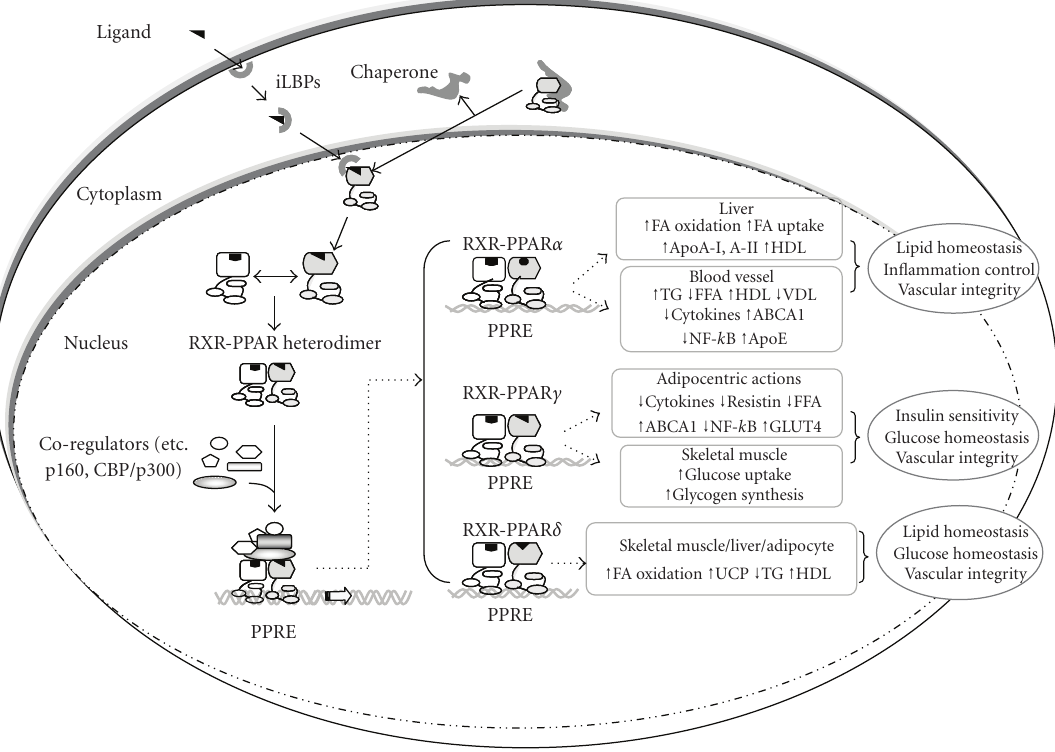
Figure 2: Signaling pathways activating PPAR and regulating the biological e ff ects of PPAR in di ff erent organs. PPAR activity can be regulated by the direct binding of small lipophilic ligands. Ligand-unbound PPAR in the cytosol is associated with chaperons, and the association changes the conformation of PPAR that allows for high-a ffi nity binding to the ligand. Ligand-bound PPAR forms a heterodimer with RXR, and the PPAR-RXR heterodimer constructs the transcriptional machinery through the recruitment of coregulators. The transcriptional machinery regulates gene expression by binding to specific DNA sequence elements, termed PPAR response elements (PPRE). PPAR α is strongly expressed in the liver, heart, and blood vessels, and regulates the expressions of genes related to lipid metabolism and inflammation control. PPAR γ exerts its e ff ects on insulin sensitivity and glucose homeostasis in adipocytes and skeletal muscles. PPAR δ is expressed ubiquitously, and controls the expressions of genes that are involved in glucose and lipid metabolism. FA: fatty acid; HDL: high-density lipoprotein; VDL: very low-density lipoprotein; ABCA1: ATP-binding cassette transporter A1; UCP: uncoupling protein; TG: